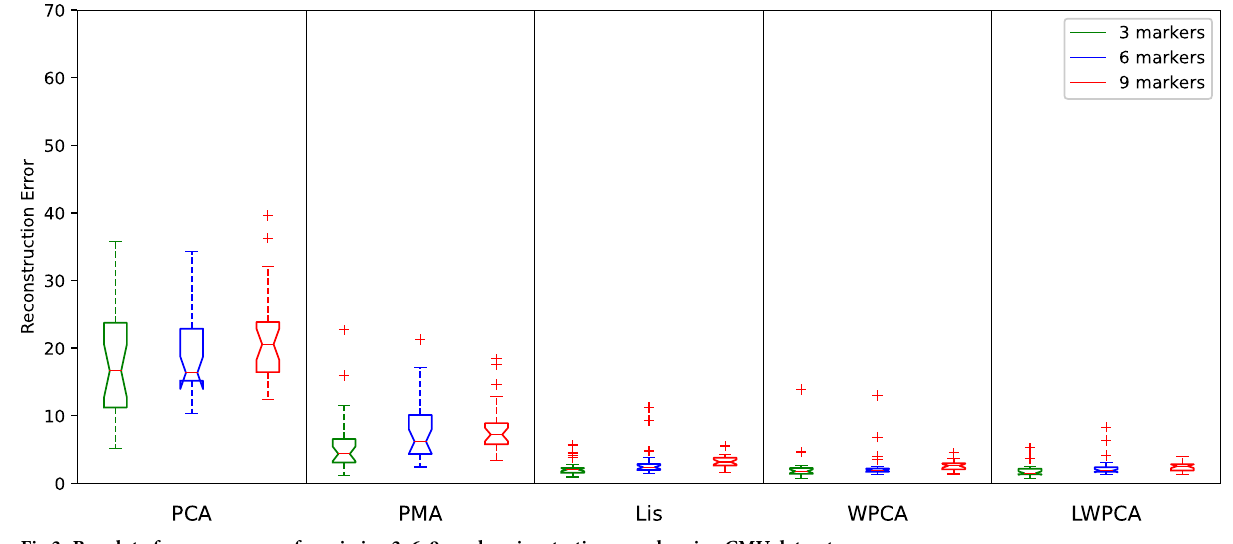
Fig 3. Boxplot of recovery errors for missing 3, 6, 9 markers in a testing sample using CMU